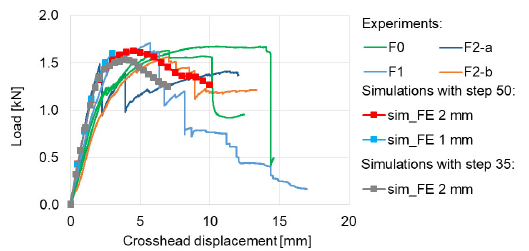
Figure 14. The effect of element size and load step size on calculated response in the CT test simulation with the pre-stress of 3 . 3 MPa, θ c = 1 . 6°, and failure type F1.